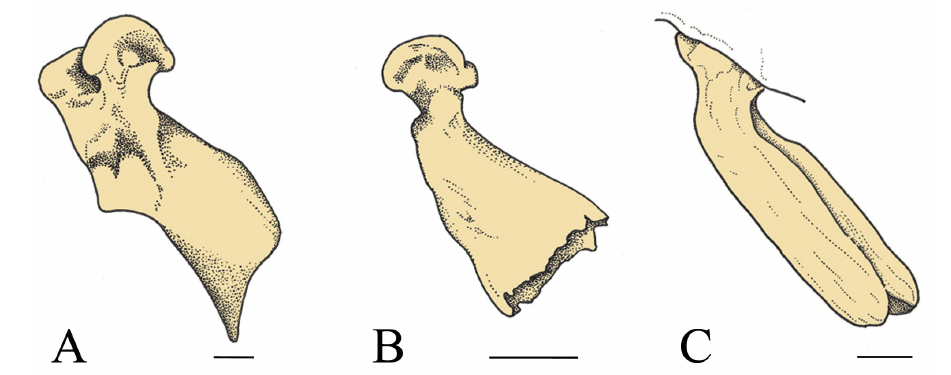
FIGURE 4 | Dorsal view of left maxillary bone; anterior up: A. Steindachneridion scriptum , MZUEL 19302; B. Rhamdia quelen , MZUEL 14631; C. Lophiosilurus apurensis , MBUCV-V-15379. Scale bars = 1 mm. 19. Premaxilla; bifurcated dorsolateral process:(0) absent; (1) present (autapomorphy). 20. Premaxillary tooth plate; form: (0) not posterolaterally extended; (1) posterolaterally extended (autapomorphy).